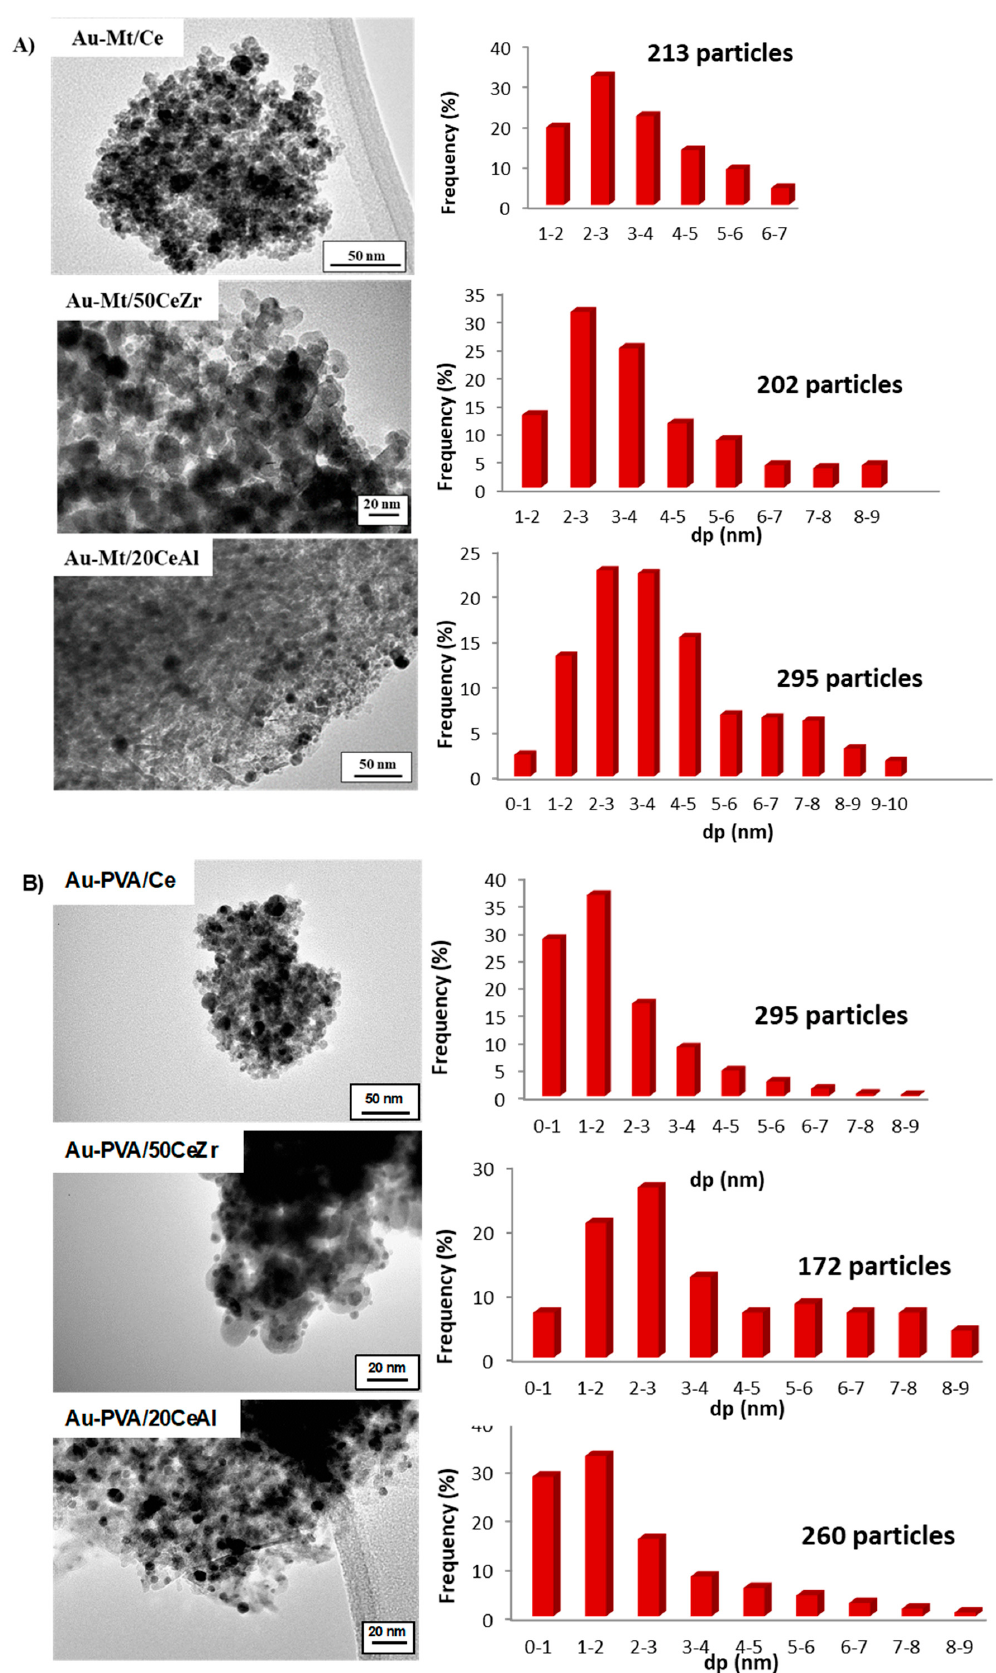
Figure 2. TEM micrographs and particle size distributions of ( A ) Mt- and ( B ) PVA-solids.